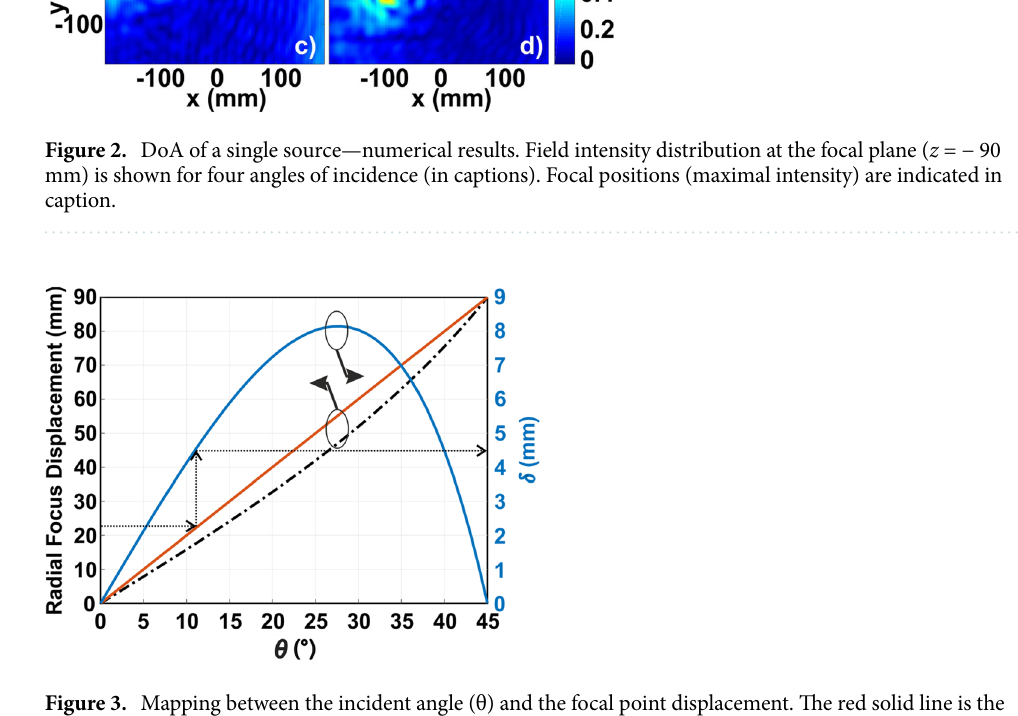
Figure 3. Mapping between the incident angle (θ) and the focal point displacement. The red solid line is the numerical prediction, the black dashed-dotted line is the ray optics prediction (3). Focal displacement is the left y-axis. The blue solid line is the difference (δ) between the numerical and analytical data, the corresponding y-axis is on the right